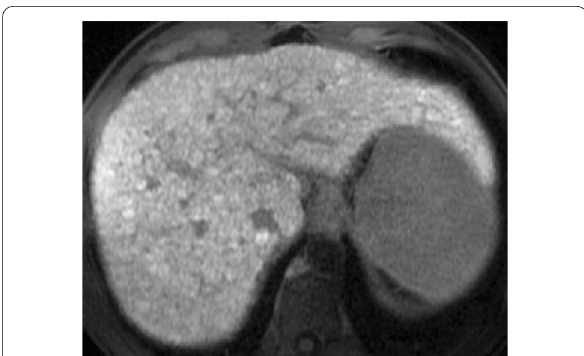
Fig. 15 A 43‑year‑old man with HCV‑related cirrhosis and multiple cirrhotic regenerative nodules. Gadoxetate disodium‑enhanced MRI shows multiple cirrhotic regenerative nodules that are hyperintense on hepatobiliary